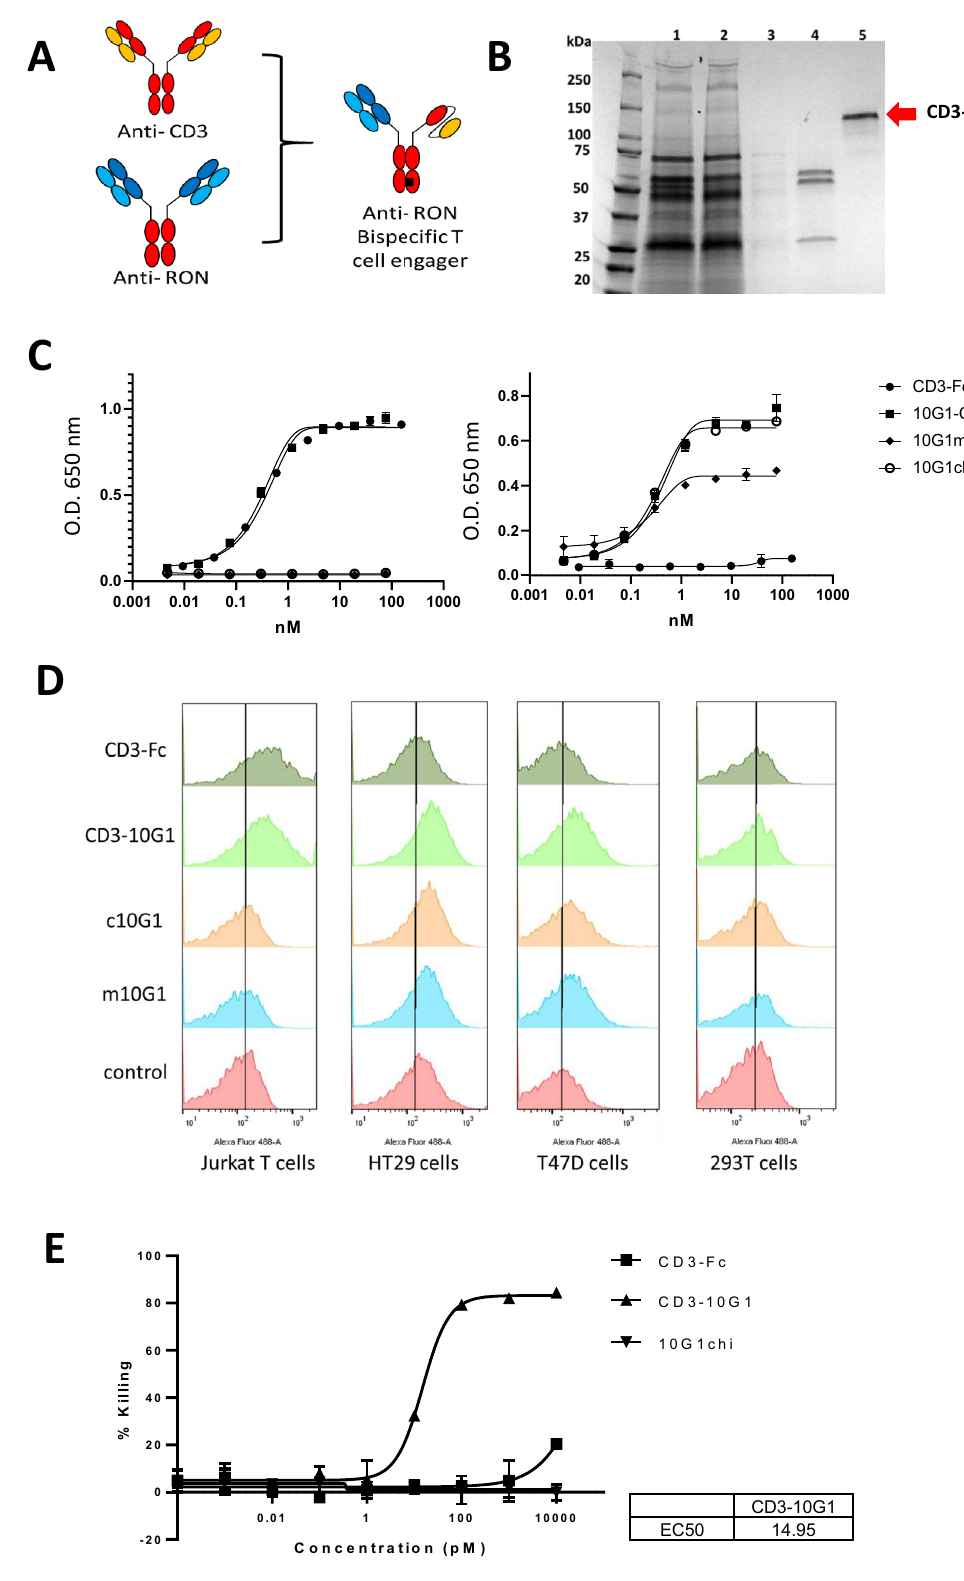
Figure 6. CD3-10G1 bispecific antibody engages T cells to kill T47D breast cancer cells in